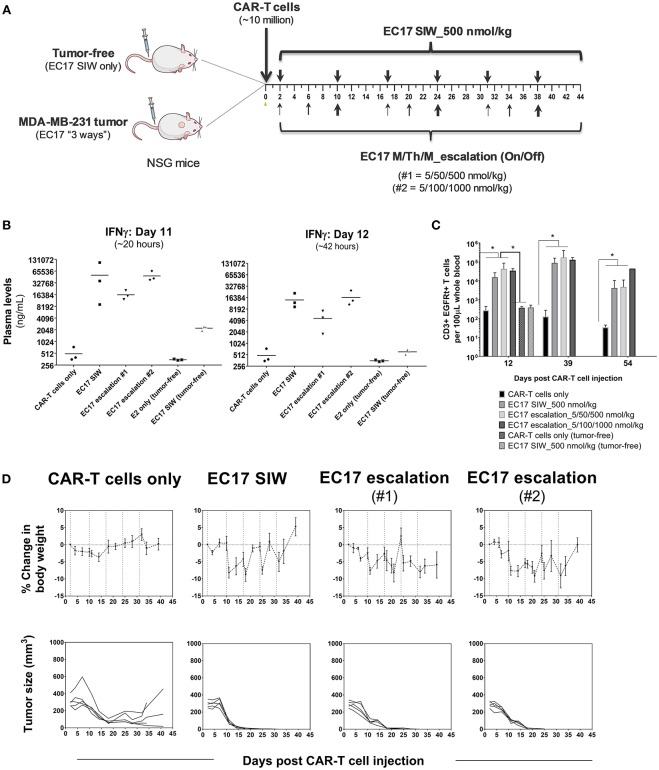
EC17 dose finding and CRS assessment in tumor vs. tumor-free mice. (A) Schematic diagram to show dose scheduling of CAR-T cells (~10 million “clinical facsimile”) plus EC17 dosed 3 different ways in NSG mice without or with pre-established MDA-MB-231 xenografts. Tumor-free mice received EC17 SIW 500 nmol/kg (2 total doses on days 2 and 10). Tumor-bearing mice received EC17 as follows: EC17 SIW 500 nmol/kg (5 total doses on days 2, 10, 17, 24, and 31), EC17 M/Th/M_Escalation-1 (repeats of 5/50/500 nmol/kg on Monday/Thursday/Monday followed by 1 week break, i.e., on days 2, 6, 10, 17, 20, 24, and 31), or EC17 M/Th/M_Escalation-2 (repeats of 5/100/1,000 nmol/kg on Monday/Thursday/Monday followed by 1 week break, i.e., days 2, 6, 10, 17, 20, 24, and 31). (B) Systemic levels of human IFNγ on a log2 scale detected in mouse plasma on days 11 and 12 after CAR-T cell injection in tumor-bearing vs. tumor-free mice (i.e., ~20 and 42 h after the previous EC17 dose in all treated cohorts). (C) Circulating CAR-T cells in mouse blood identified as human CD3ε+ EGFRt+ events by flow cytometry and enumerated per 100 μL of whole blood. (D) Measurements of change in body weight and tumor volume in tumor-bearing mice that received CAR-T cells only or CAR-T cells plus EC17 dosed 3 different ways (dashed lines indicated each EC17 dose). n = 5 mice per group. All data represent mean ± s.e.m. *p < 0.05 by one-way ANOVA test.